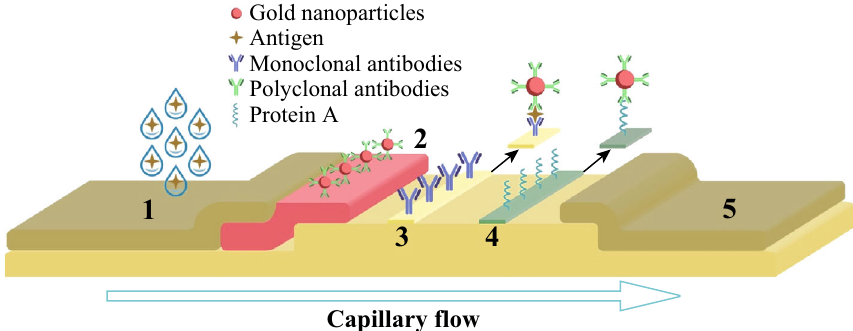
Fig. 1 Scheme of LFIA using gold nanoparticles as labels: (1) Sample pad, (2) Conjugate pad, (3) Test line, (4) Control line, (5)